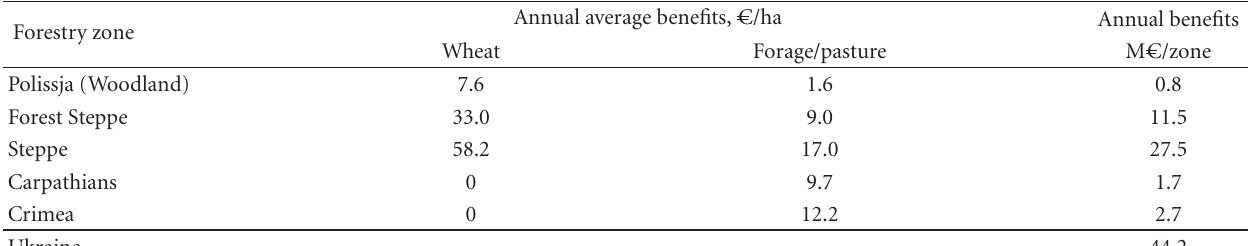
Table 6: Estimates of soil protection benefits to